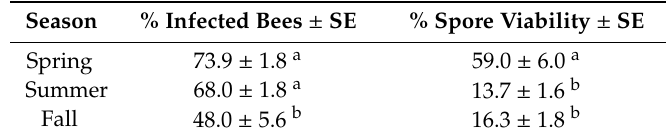
Figure 1. Nosema ceranae infection intensity (mean No. spores / bee ± SE) of honey bee colonies during spring, summer and fall ( n = 179). Different letters indicate significant differences between seasons based on analyses of variance and Tukey tests of arcsine-square root transformed data at a significant level of < 0.05. Actual data are presented. Table 1. Prevalence and viability of Nosema ceranae spores in honey bee colonies during spring, summer and fall ( n = 30).